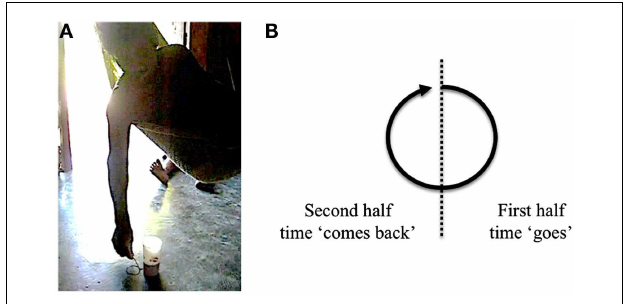
FIGURE 2 |Tracing of time flow as cyclic. (A) Man tracing several circles with a stick. (B) Schema of his tracing.